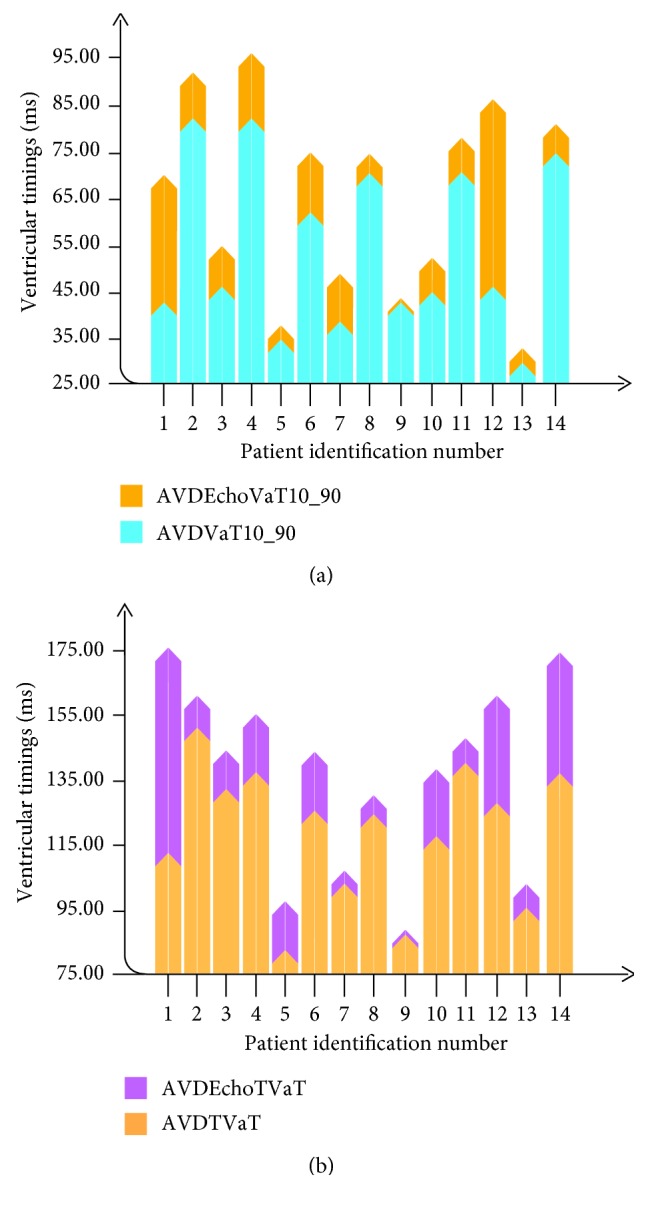
Activation timings for the optimal AVD obtained by the iterative method versus the shortest ventricular activations obtained for each patient. AVD, atrioventricular delay; AVDEchoTVaT, TVaT obtained based on the optimal AVD obtained through echocardiographic methods; AVDEchoVaT10-90, VaT10-90 index obtained based on the optimal AVD obtained through echocardiographic methods; AVDVaT10-90, shortest VaT10-90 index obtained for the AVD tested; AVDTVaT, shortest TVaT obtained for the AVD tested; XX patient identification number.